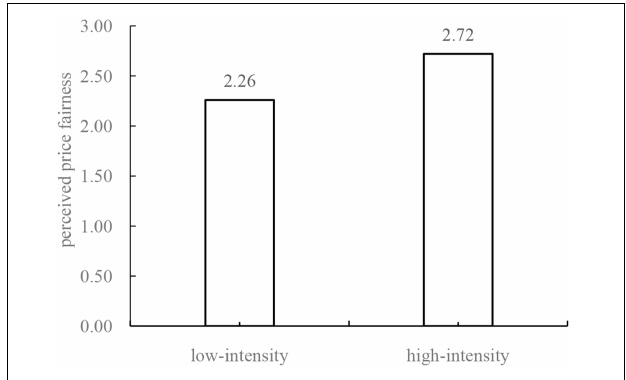
FIGURE 3 | The mediating role of perceived price